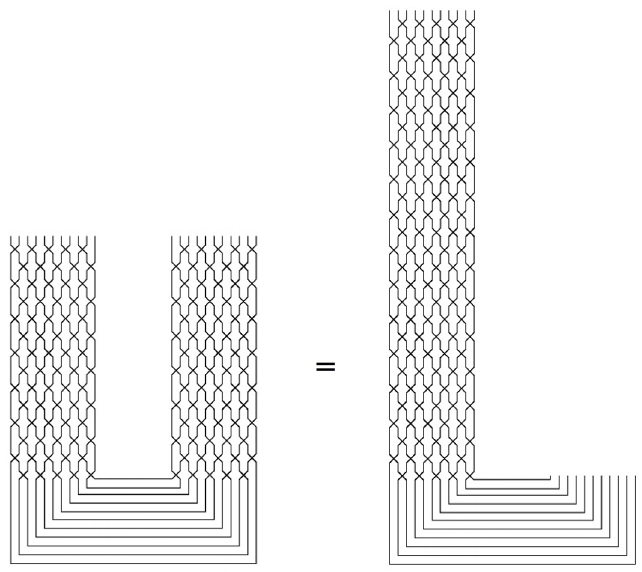
Figure 3 . Left: the quantum circuit that prepares U A ( t ) (cid:10) U B ( t ) j TFD i . Right: the quantum 1 circuit that prepares U A (2 t ) TFD . The two states are the same. (cid:10) j i on one side. 4 We will sometime use C R;A to indicate that the restriction is on a speci(cid:12)c subsystem ( A in this case). Without loss of generality we can assume the gates all act on Alice’s side or we may distribute them symmetrically between the two sides. A useful picture is provided by the tensor network (TN) description. The state (cid:9) is represented j i as a TN as in (cid:12)gure